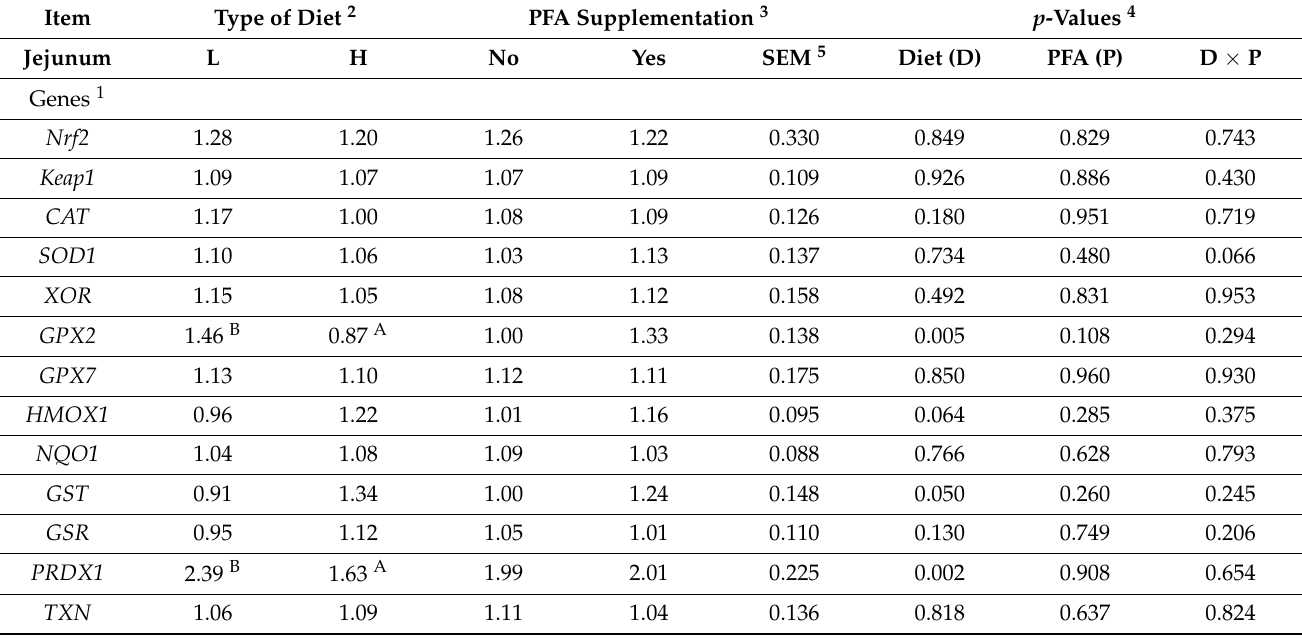
Table 4. Relative expression of the Nrf2 /ARE pathway genes in the jejunal mucosa of 42-day-old